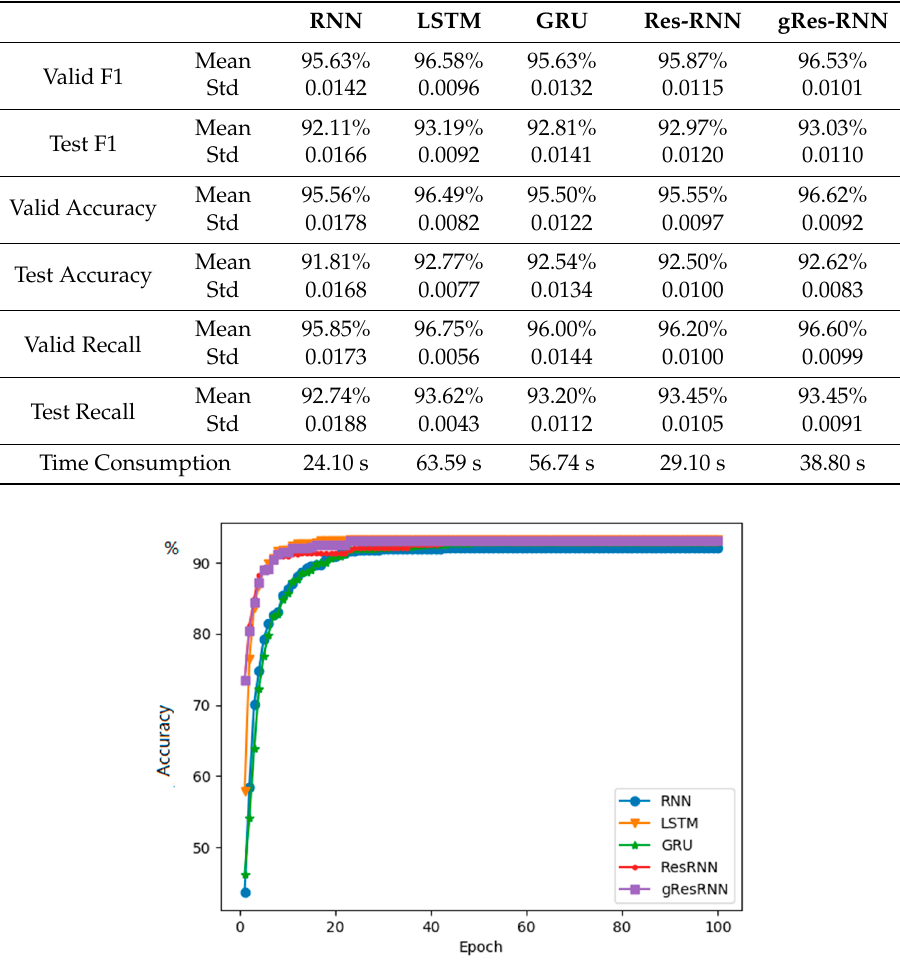
Table 1. Average performance of the RNN [9], LSTM [16] and GRU [17], Res-RNN and Res-RNN with gates on airline travel information system (ATIS) database [22] in 100 epochs.